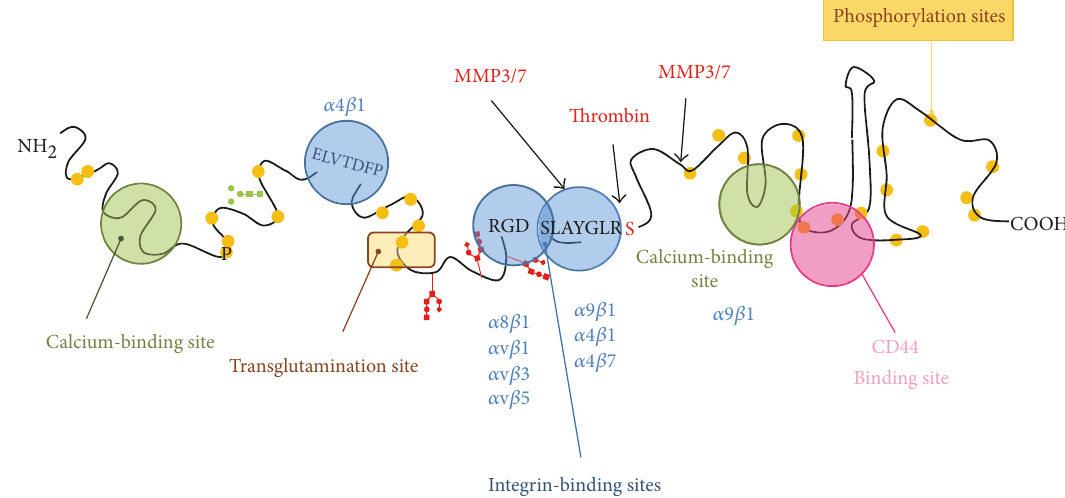
Figure 2: Main domains of OPN. The cartoon depicts the functional parts of OPN. OPN binds two di ff erent classes of receptors, integrins (in blue) and CD44 (in pink). It can also interact with calcium (green). The SVVYGLR sequence is usually masked in the full- length molecule, but it becomes available upon thrombin cleavage of OPN. OPN undergoes several posttranslational modi fi cations including glycosylation (red and green sugars), phosphorylation (yellow dots), crosslinking mediated by transglutaminase and protease cleavage (thrombin and MMPs). Each of these modi fi cations can alter OPN